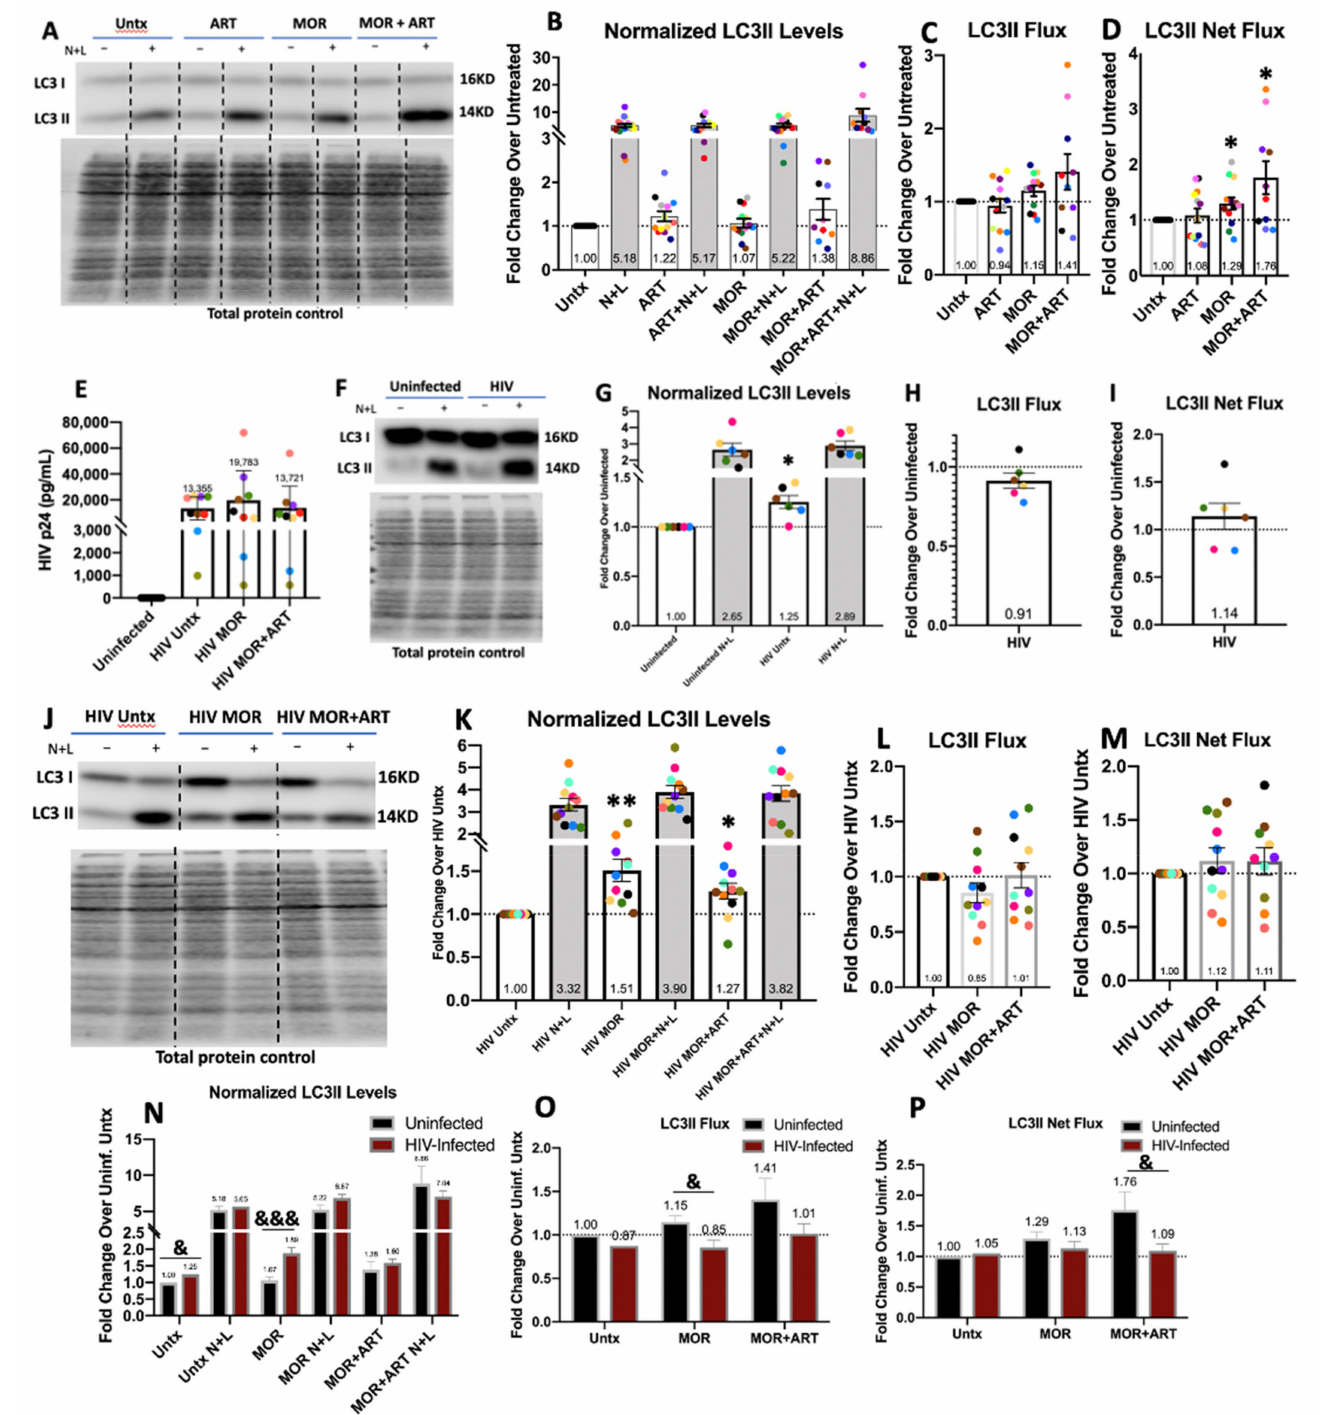
Figure 1. Normalized LC3II levels, LC3II flux, and LC3II net flux analyzed by Western blotting in uninfected and HIV- infected primary human MDM. Primary human MDM were cultured from PBMC and either left untreated (Untx) or treated with morphine (MOR: 100 nM) and/or antiretroviral therapy (ART: 15 µ M tenofovir, 15 µ M emtricitabine, 1 µ M